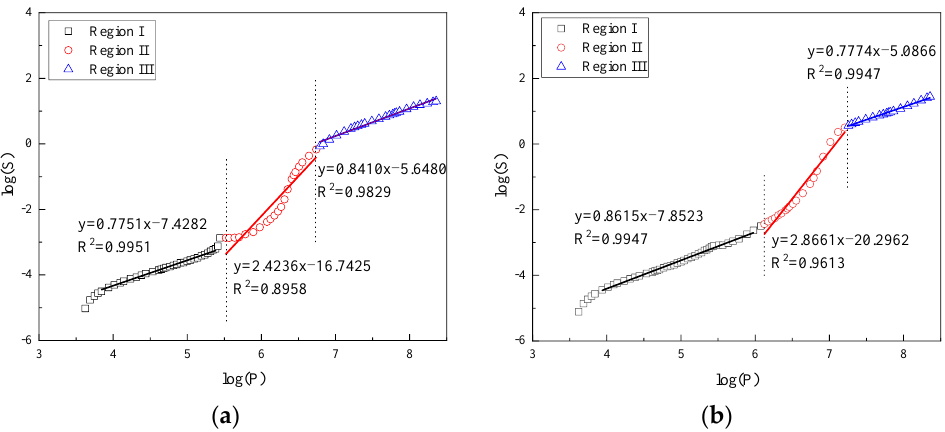
Figure 4. Multifractal characteristics of OPC0 at different ages under Neimark’s model. ( a ) 3 days, ( b ) 28 days.